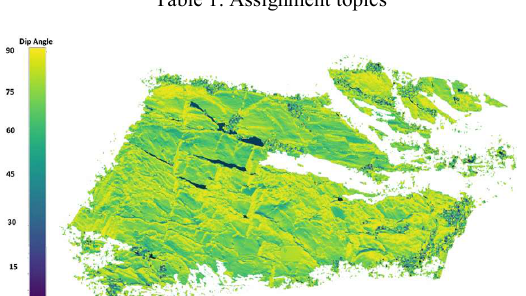
Figure 2: Local dip angles or inclinations of the rock face considered in Assignment 1. A dip angle of 90 degrees indicates a locally vertical rock